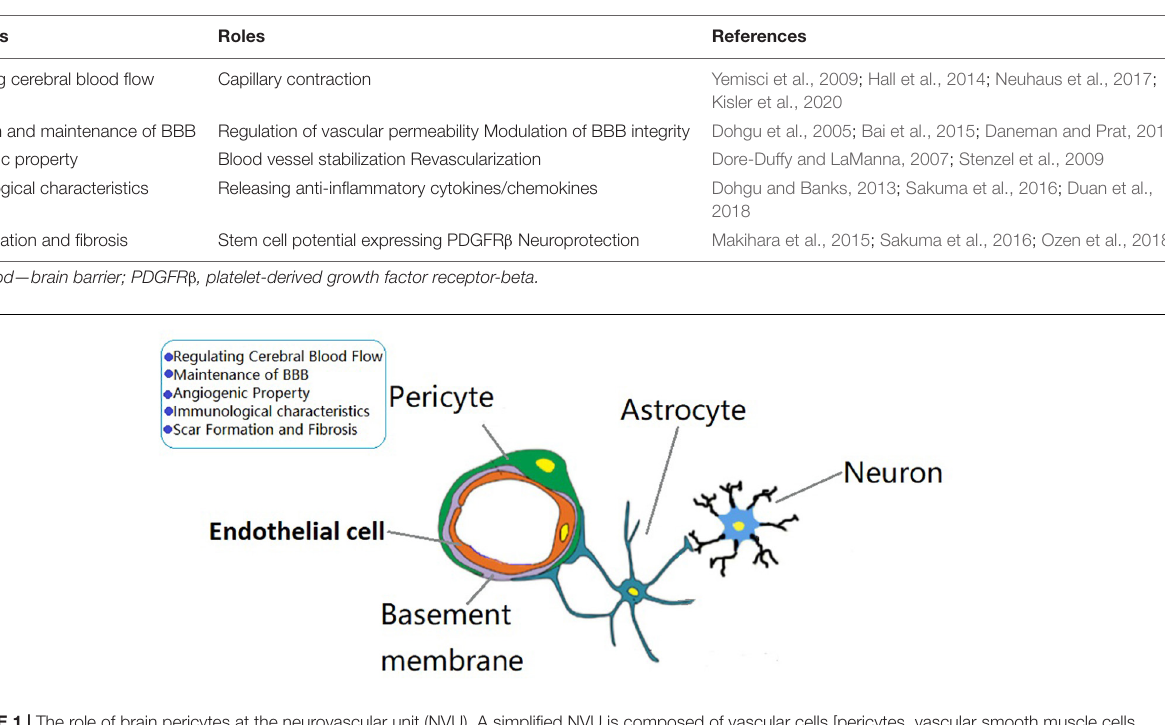
TABLE 1 | Functions of pericytes in ischemic stroke.